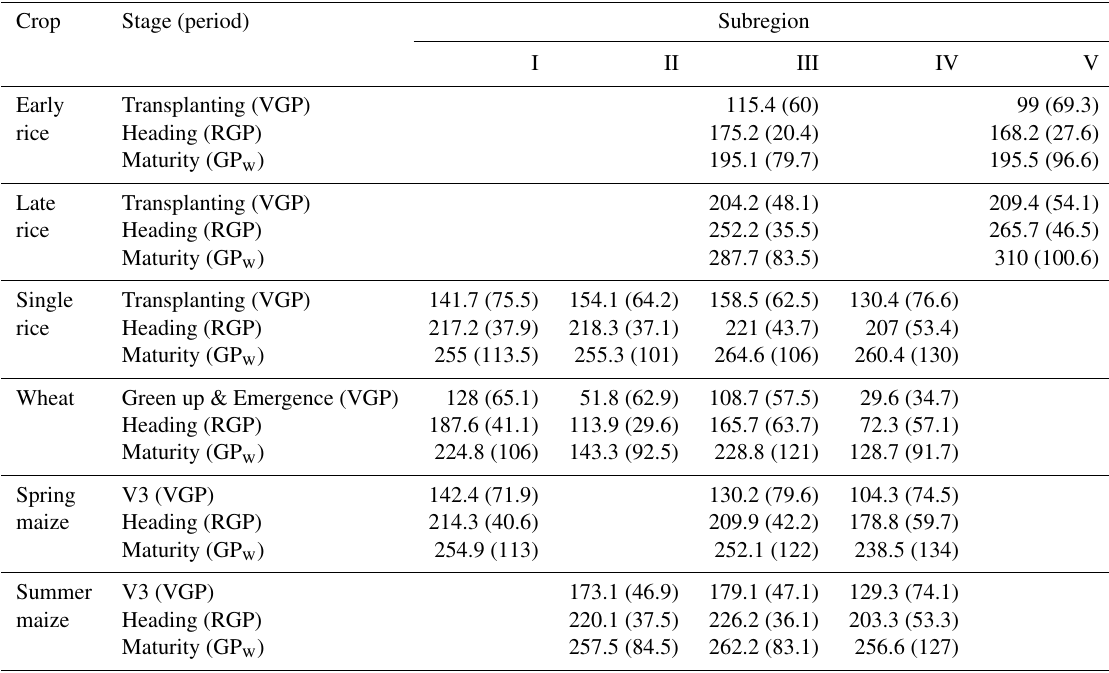
Table 3. Annual mean phenological dates and growth periods of different crops in each subregion.